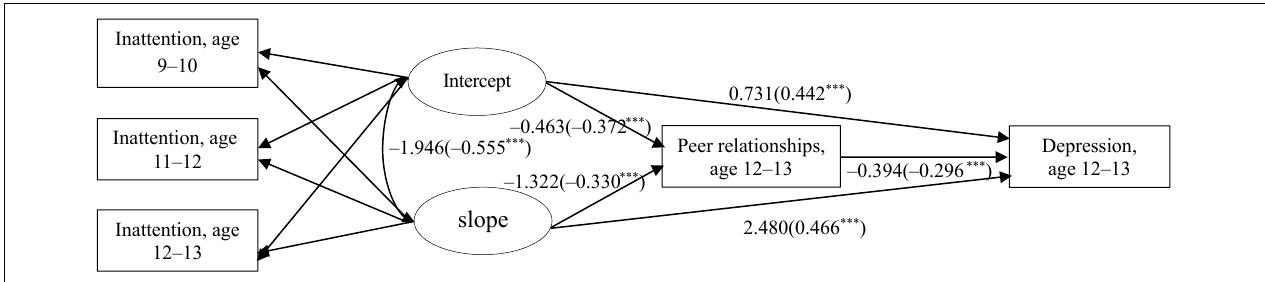
FIGURE 1 | Results of latent growth modeling (LGM) (Panel 1). Peer relationship at age 12–13 and depressive symptoms at age 12–13 were controlled for child sex. Parameters in parentheses are standardized coefficients. *** p <